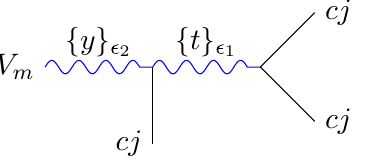
Fig. 2 Diagram related